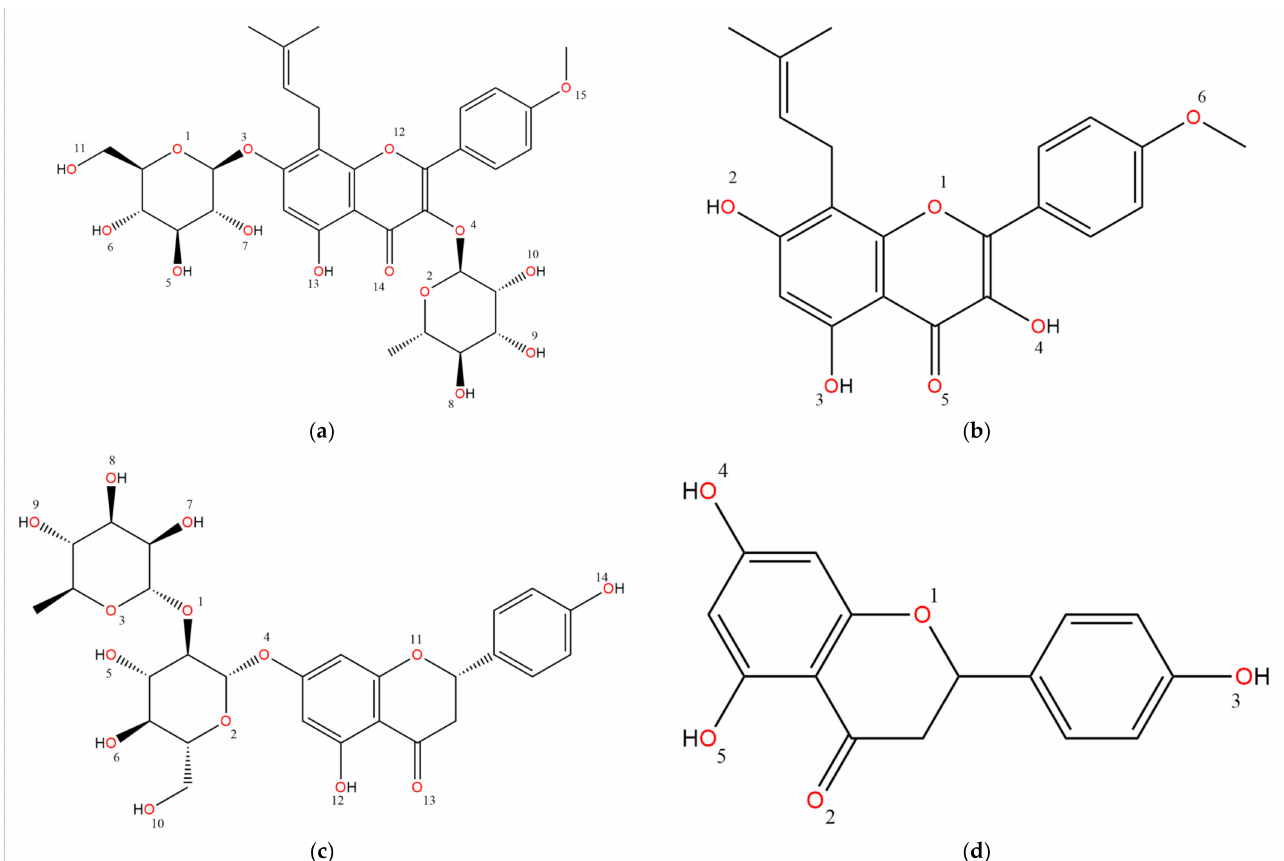
Figure 1. Chemical representation of ( a ) icariin, ( b ) icaritin, ( c ) naringin, and ( d ) naringenin